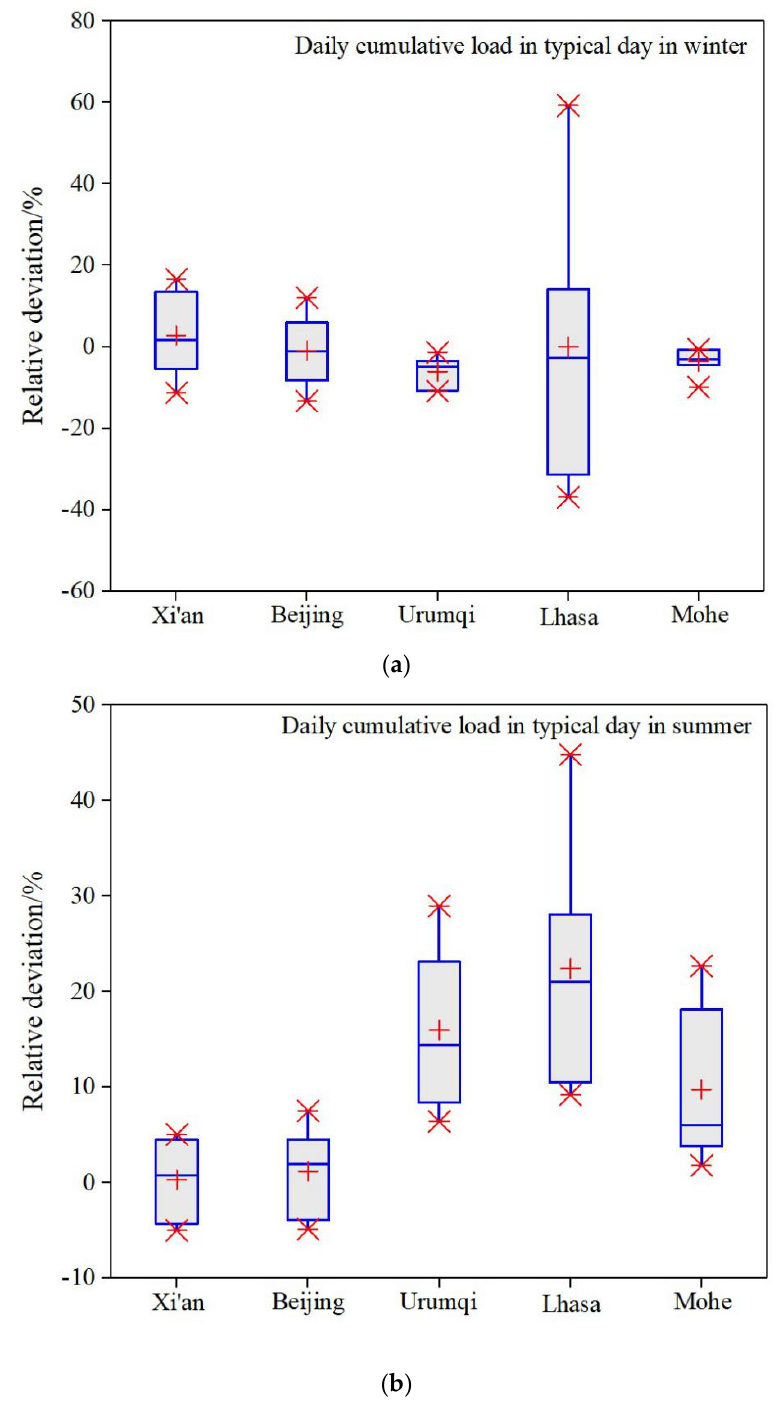
Figure 10. Boxplots showing the relative deviations in the daily cumulative load on a typical day with different SHTCs: ( a ) Daily cumulative load on a typical day in winter; ( b ) Daily cumulative load on a typical day in